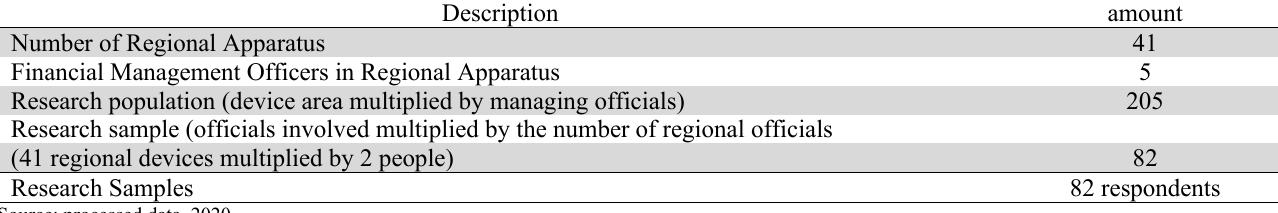
Overview of Research Sample